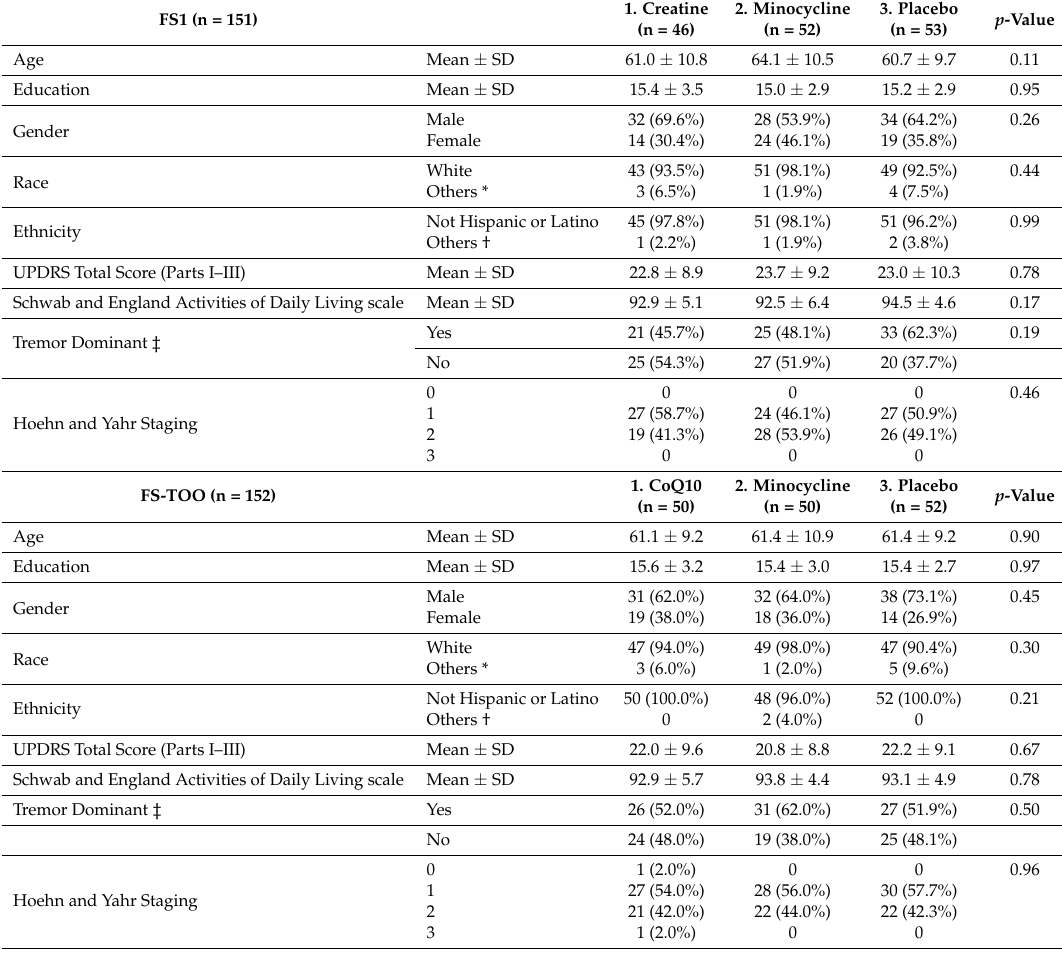
Table 1. Demographic and disease characteristics of participants at